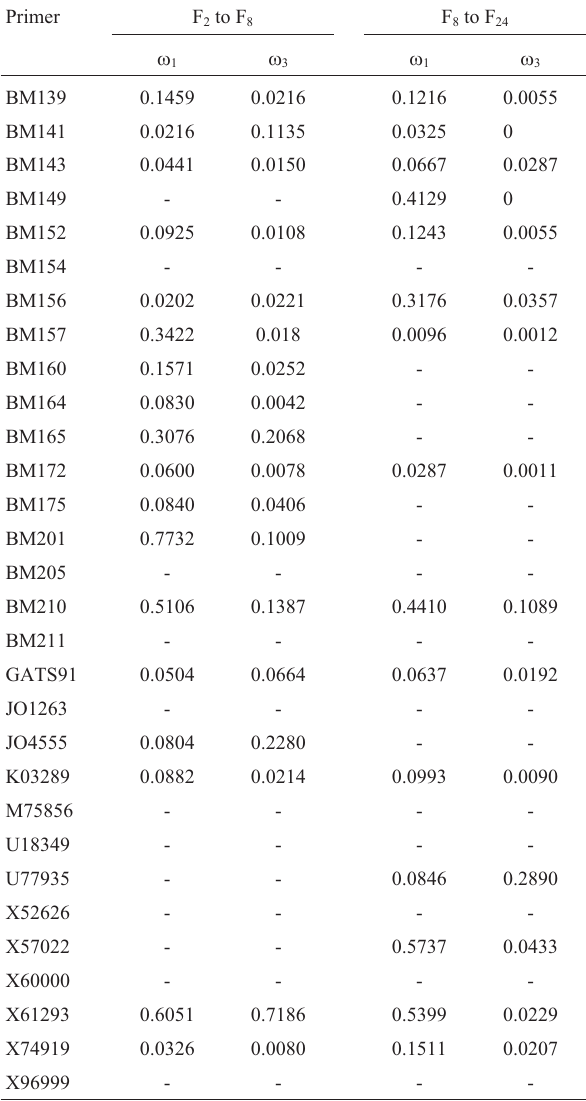
Table 3 - Estimates per microsatellite locus of the coefficients of accumulated relative fitness ( ω 1 and ω 3 ) in the F 8 and F 24 generations of a P. vulgaris cultivar Carioca MG and ESAL 686 cross. The table shows the results for 30 microsatellite